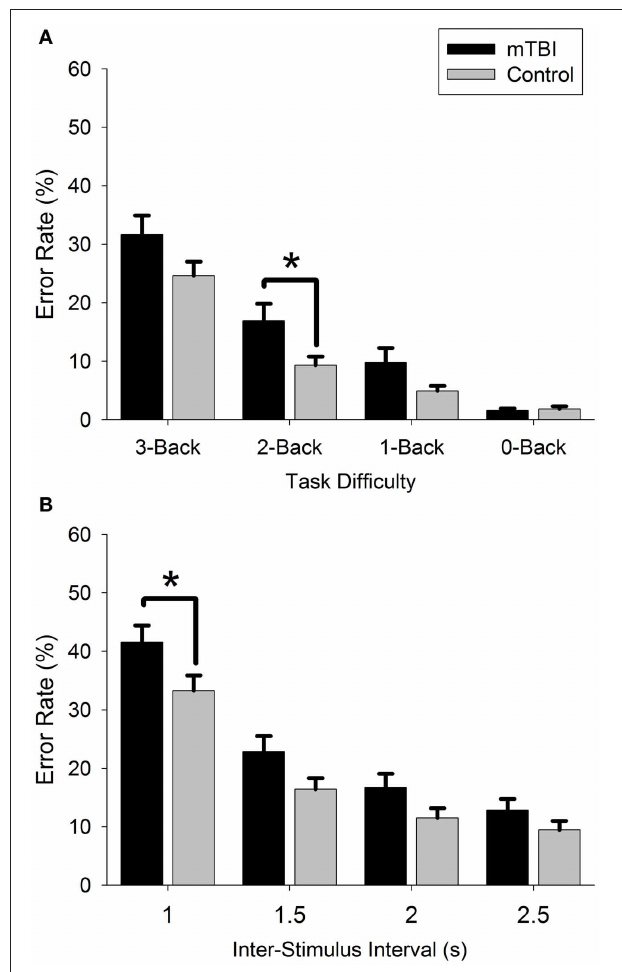
FIGURE 3 | Comparison of mTBI and control error rate for (A): n-Back and (B): PVSAT tasks. ∗ p < 0 .